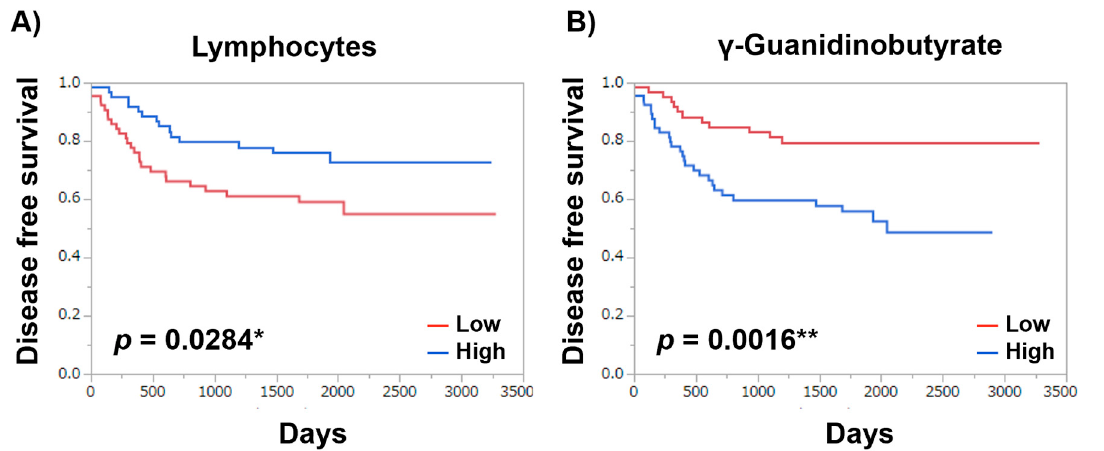
Figure 7. Kaplan–Meier curves of disease-free survival. ( A ) Lymphocytes and ( B ) γ - Guanidinobutyrate. NLR ≥ 3 and median value of γ -Guanidinobutyrate were used as thresholds to categorize the patients into high and low groups. p -value was calculated using the Log-rank test. p < 0.05 *, p < 0.01